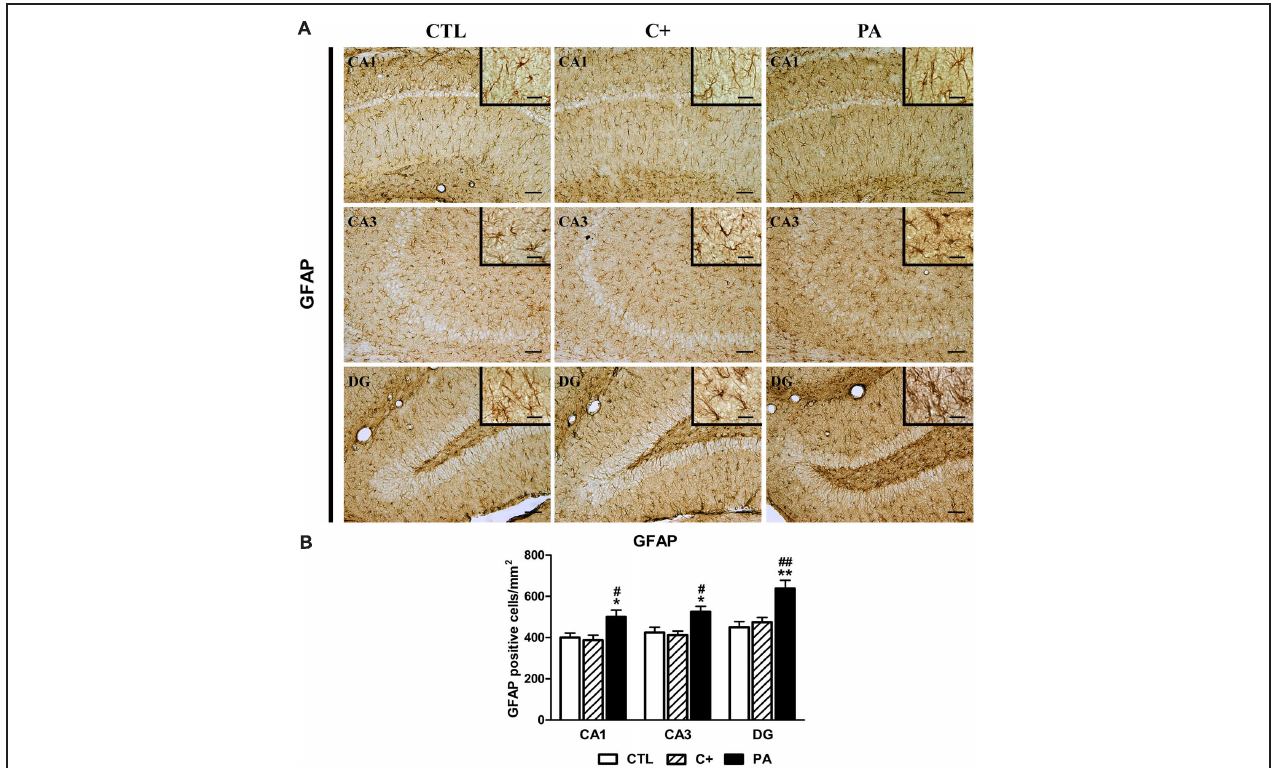
FIGURE 3 | Glial fibrillary acidic protein (GFAP) immunostaining in dorsal hippocampus. (A) Representative photomicrographs showing GFAP-positive cells in CA1, CA3, and DG regions of the dorsal hippocampus in the different experimental groups. Scale bars = 15 and 3 μ m in insets. (B) Quantification of the number of GFAP-positive cells in CA1, CA3, and DG regions of the dorsal hippocampus in the different experimental groups. Bars and error bars show the mean + SEM of 5–7 observations per animal of a total of six rats per group. ∗ p < 0.05 vs. CTL; ∗∗ p < 0.01 vs. CTL; # p < 0.05 vs. C + ; ## p < 0.01 vs. C + . CTL, control group; C + , cesarean section group; PA, perinatal asphyxia group; CA1, cornu ammonis 1; CA3, cornu ammonis 3; DG, dentate